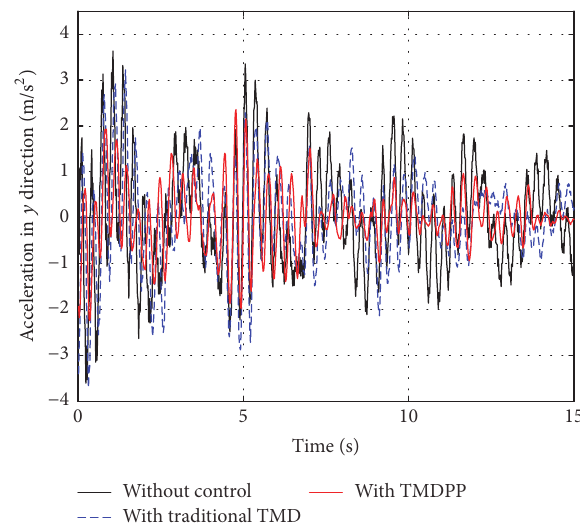
Figure 8: Damping comparison of structural acceleration in 𝑥 direction.